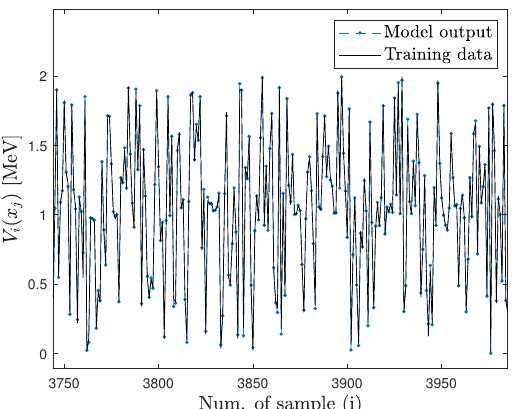
Figure 7. Comparison of the training data with the output of the identified 5th order Volterra system. The black lines are the training samples, while the blue dotted lines are the model outputs.